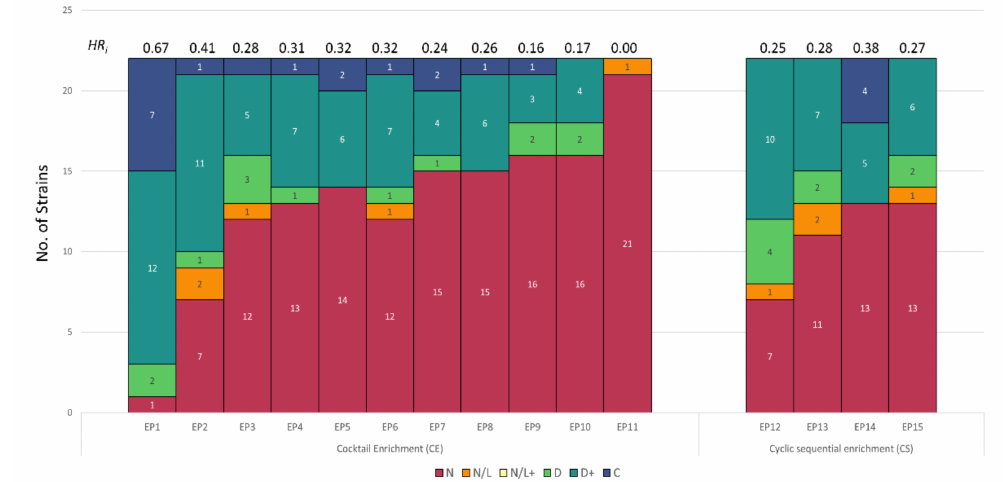
Figure 6. Stacked bar plot showing the host range of phages infecting Pseudomonas clinical strains isolated using different enrichment methods. Designation: C, complete inhibition, D+, >5 h delay to reach exponential phase; D, <5 h delay to reach exponential phase; N, no effect; HR i , host range